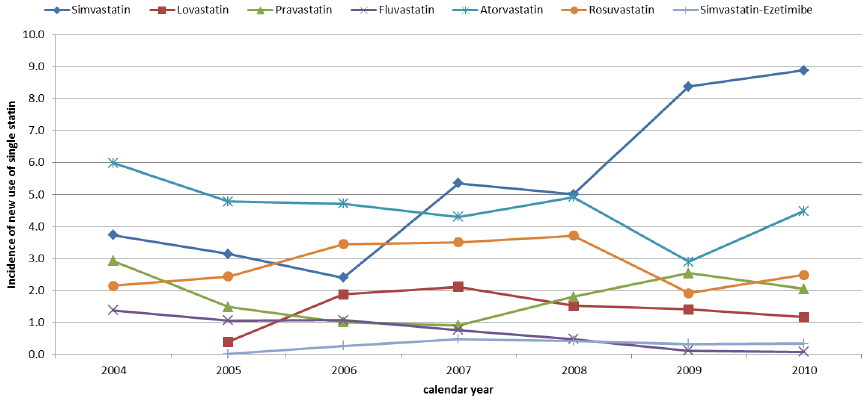
Figure 3. Yearly incidence of statin use stratified by individual compound.